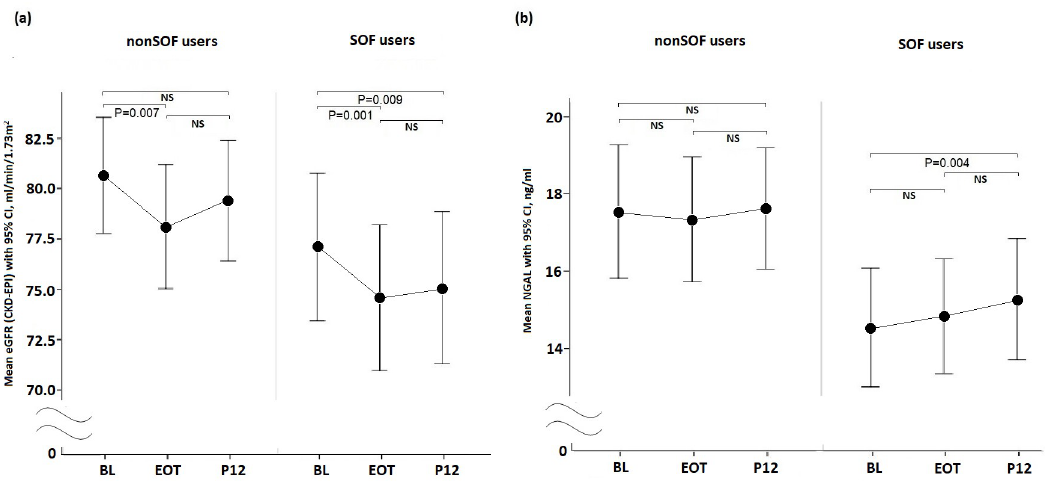
Fig 3. The eGFR and NGAL changes from the BL, EOT to P12 in nonSOF-based or SOF-based DAA subgroups. a. eGFR; b.